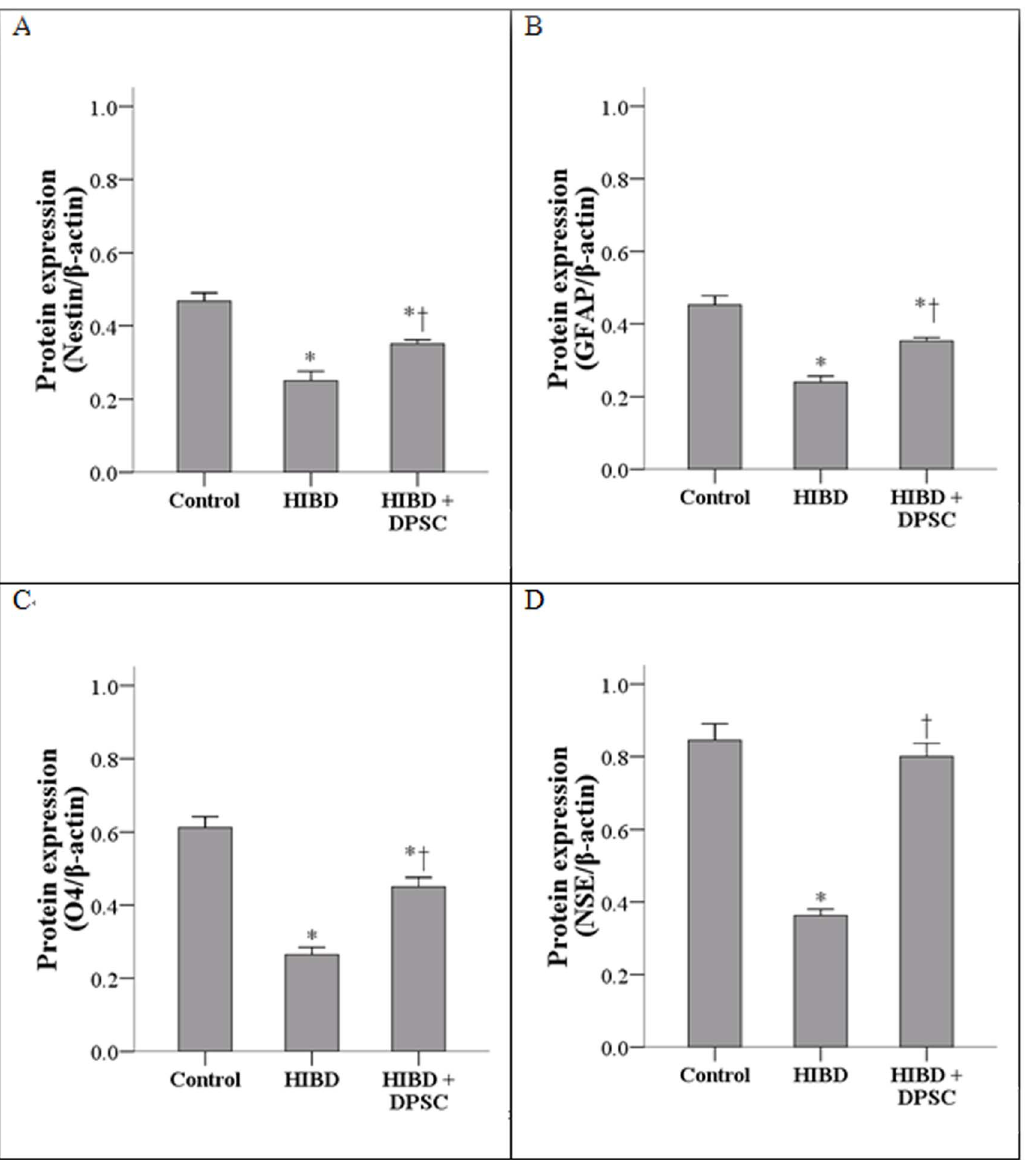
Figure 3. Protein expression levels were performed by Western blot. Four groups are nestin (A), GFAP (B), O4 (C), and NSE (D). Data are presented as mean and standard deviation (n=4 for each group). for nestin (A), GFAP (B), O4 (C), and NSE (D)*Significant difference compared to control group (P , 0.0001). { Significant difference compared to HIBD group (P , 0.0001). DPSC: dental pulp stem cells; GFAP: glial fibrillary acidic protein; HIBD: hypoxic-ischemic brain damage; NSE: neuron-specific enolase; O4: oligodendrocyte marker